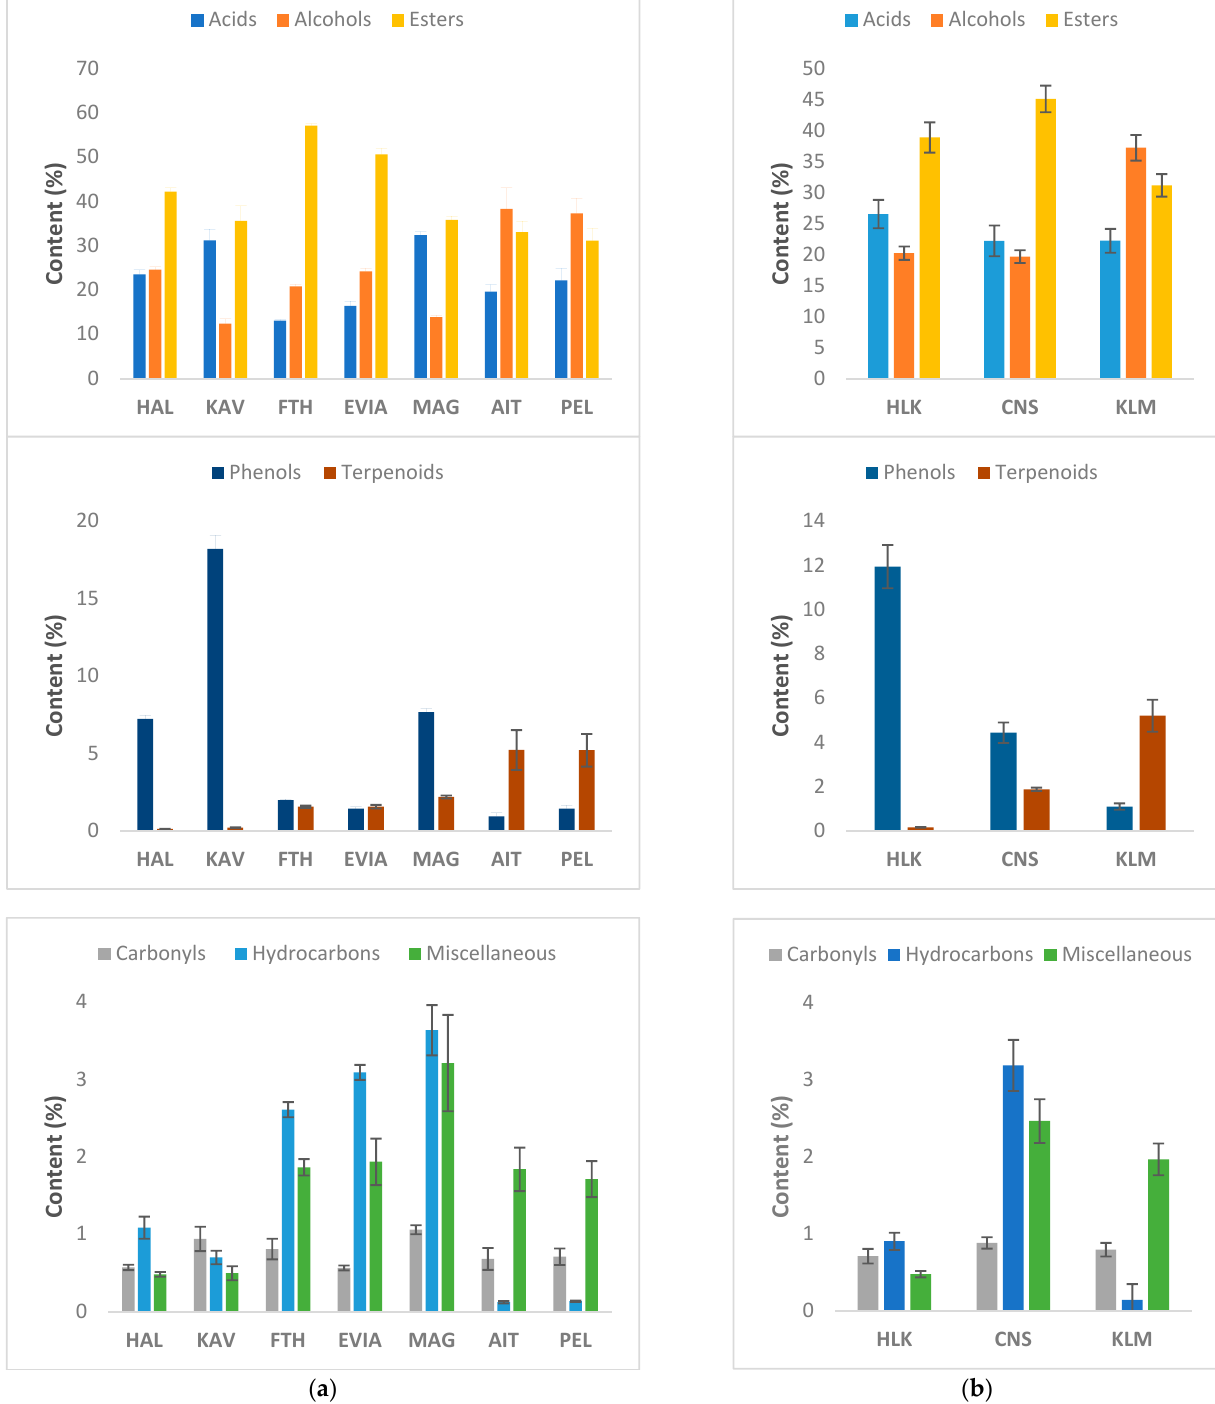
Figure 1. Comparison of the relative content (%) of chemical classes of the volatile compounds identified in industrially fermented table olives originating from various ( a ) growing locations (HAL: Halkidiki; KAV: Kavala; FTH: Fthiotida; EVIA: northern Evia; MAG: Magnesia; AIT: Aitoloakarnania; PEL: Southern Peloponnese) and ( b ) cultivars (HLK: Halkidiki; KLM: Kalamata; CNS: Conservolea). The error bars indicate standard errors at 95% confidence level.